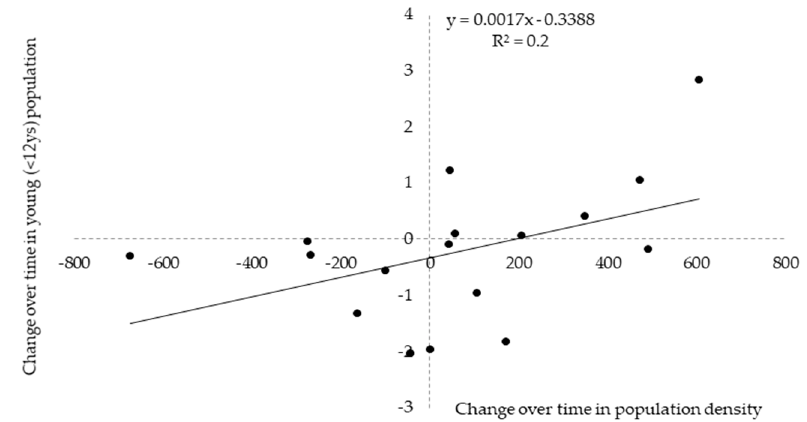
Figure 9. The relationship between population growth (%, 2006–2018) and the percent share of young population (age < 12 years) in total resident population of 19 coastal districts of Rome’s municipality.